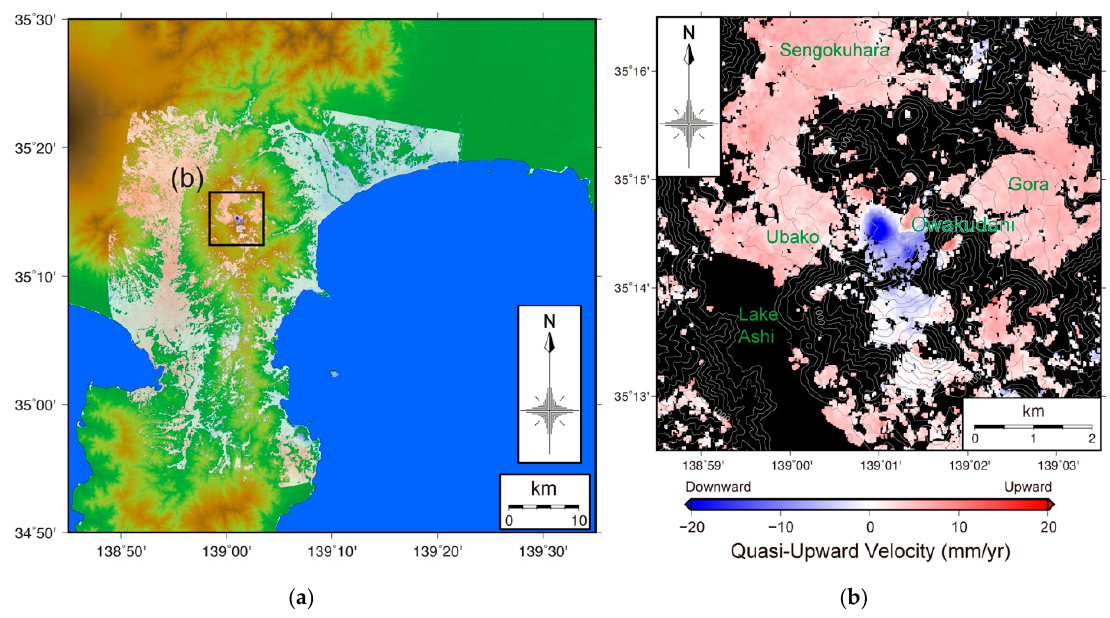
Figure 8. Distribution of quasi-upward velocity over the ( a ) entire region; ( b ) area of interest shown in the black rectangle (inset) in ( a ). The base map of ( a ) is a topographical map based on 10 m mesh height data released by the GSI, and its color scale is the same as Figure 1. Intervals of contour lines in ( b ) are 50 m in height.